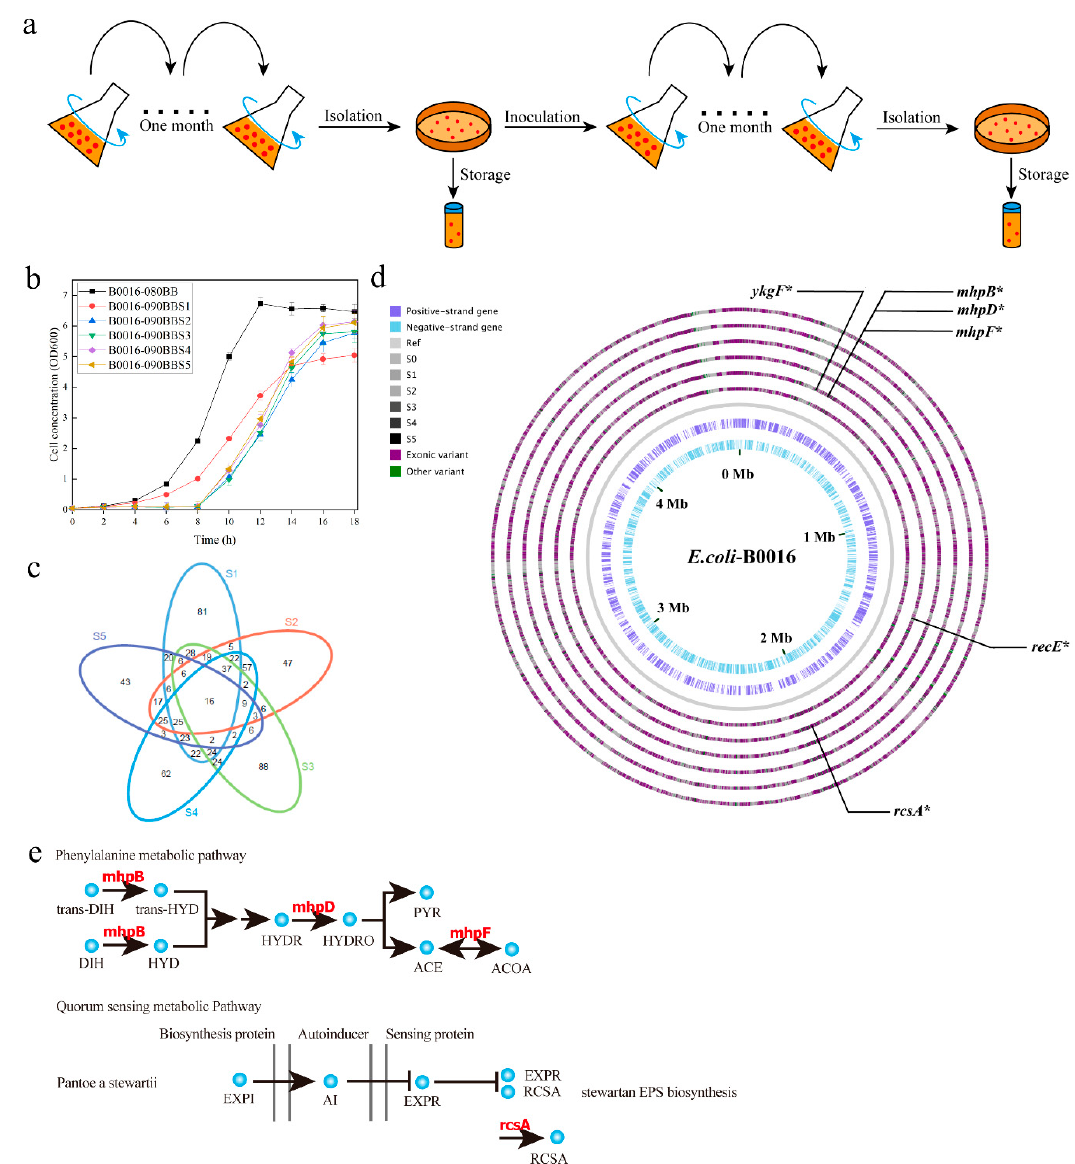
Figure 2. The method and results of ALE experiment. ( a ) The process of ALE experiment. ( b ) The growth curve of the adapted mutants. ( c ) Consistent mutations among the adapted mutants. ( d ) Genetic mutations of the mutants. Rings from outer to inner represent the genomic information of B0016-090BBS5, B0016-090BBS4, B0016-090BBS3, B0016-090BBS2, B0016-090BBS1, and B0016-090BB and the reference genome from the NCBI database. S0: B0016-090BB, S1: B0016-090BBS1, S2: B0016-090BBS2, S3: B0016-090BBS3, S4: B0016-090BBS4, S5: B0016-090BBS5. ( e ) The metabolic pathways associated with the genetic mutation library of the adapted mutant pool. DIH: 2.3-dihydroxycinnamate, HYD: trans- -hydroxy-6-oxonona- trienedioate, HYDR: cis-2-hydroxypenta-2,4-dienoate, HYDRO: 4-hydroxy-2-oxopentanoate, PYR: pyruvate, ACE: acetal- dehyde, ACOA: acetyl-CoA, EXPI: acyl homoserine lactone, AI: N-(3-oxohexanoyl)-L-homoserine lactone, EXPR: LuxR family transcriptional regulator, quorum-sensing system regulator ExpR, RCSA: LuxR family transcriptional regulator, capsular biosynthesis positive transcription factor.